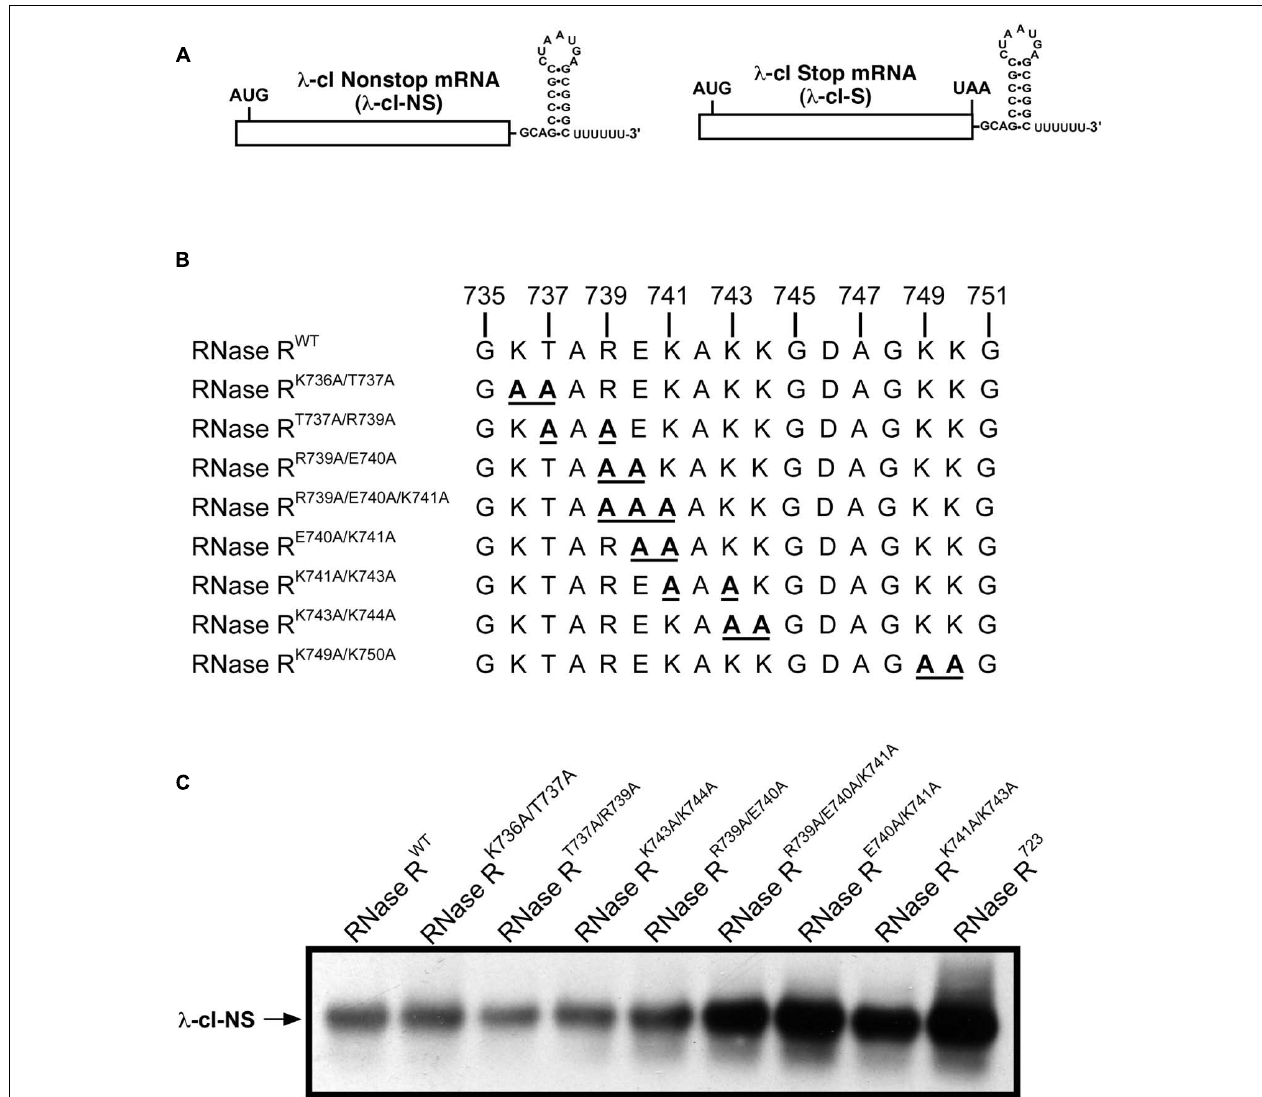
FIGURE 2 | Steady state level of non-stop reporter mRNA. (A) A schematic representation of the reporter mRNAs used in this study.The λ -cI non-stop reporter ( λ -cI-NS) is composed of the coding region of λ -cI N-terminal domain (depicted as a rectangle) followed by the transcriptional terminator ( trp At nucleotide sequence at the 3 (cid:2) end).The corresponding λ -cI stop reporter ( λ -cI-S) has an in-frame UAA stop codon before the transcriptional terminator. ( B) A representation of alanine substitutions in the region between amino acids 735 and 750 of the K-rich domain. ( C) A